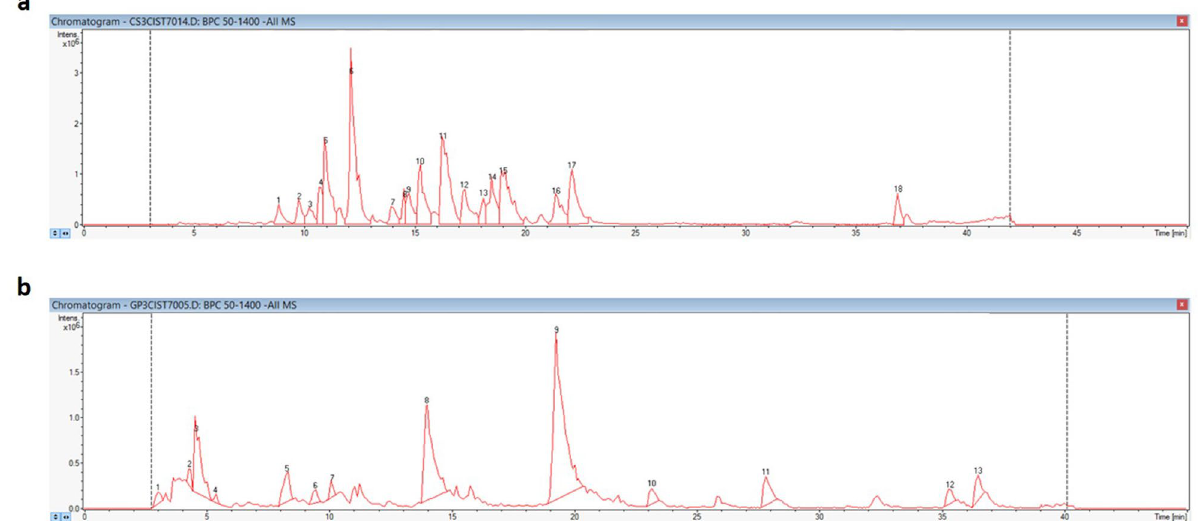
Figure 2. Base peak chromatograms of the CS ( a ) and GP extract ( b ) obtained by HPLC